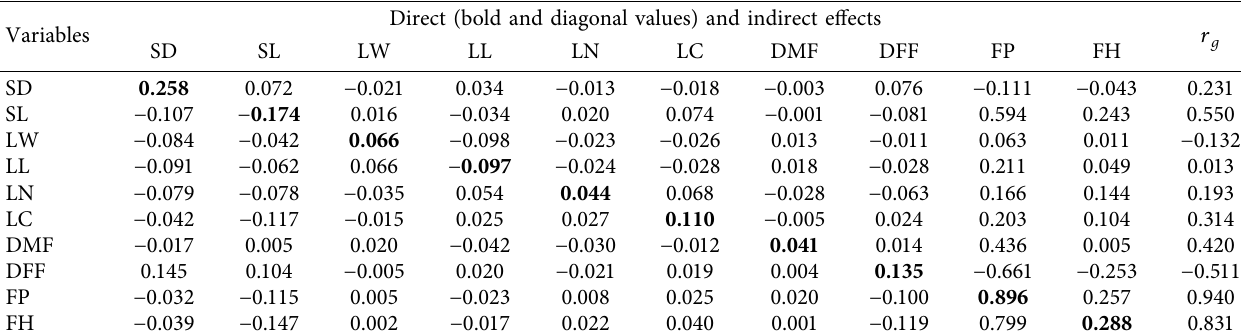
Table 4: Genotypic path analysis among melon characteristics on fruit